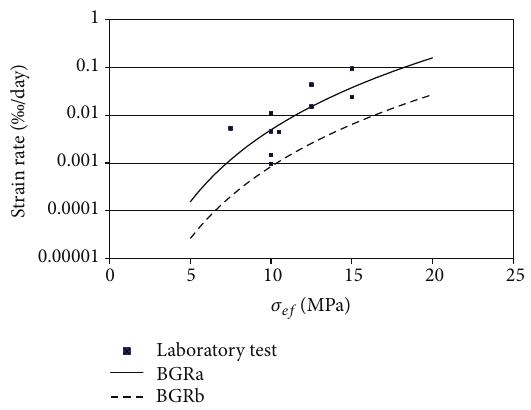
Figure 7: Comparison of stationary creep rate of rock salt samples (tests done in 1991—mean values, in 2001—all the values) with BGRa and BGRb